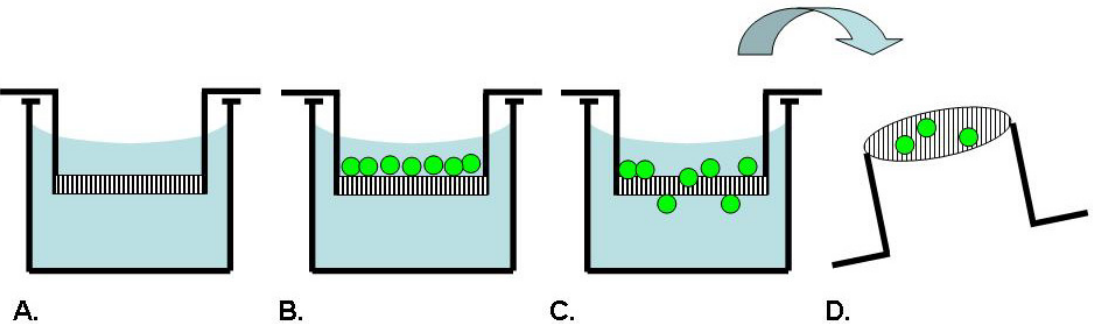
Figure 2. Transmembrane/Boyden Chamber Assay. A membrane insert is used to establish 2 compartments in a well ( A ). Cells are added to the upper compartment ( B ) and migrate through the membrane ( C ). Cell migration is measured by counting the number of cells on the underside of the membrane ( D ). Assay options include coating the membrane with a matrix protein and adding a chemoattractant to the lower